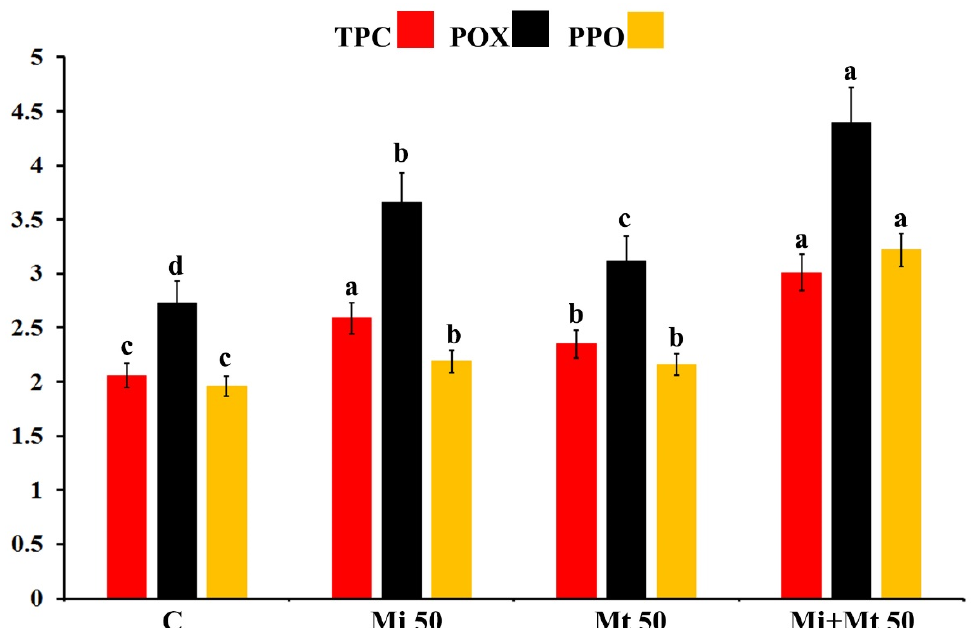
Figure 2. Histogram showing the total phenolic content (TPC, mg gallic acid equivalent/g fresh weight), and activity of peroxidase (POX, ∆ A470 min − 1 g − 1 fresh weight) and polyphenol oxidase (PPO, ∆ A 420 min − 1 g − 1 fresh weight) enzymes in date palm fruits (cv. Barhi) after 28 days of storage at 4 °C, in response to spraying with methyl jasmonate and/or melatonin solutions at 50 ppm. Where, C = untreated control fruits, Mj 50 = treated with methyl jasmonate at 50 ppm, Mt 50 = treated with melatonin at 50 ppm, and Mj + Mt 50 = treated with methyl jasmonate and melatonin at 50 ppm. For each parameter, columns superscripted with the same letter are not significantly different according to Tukey’s HSD test ( p ≤ 0.05). Each value represents the mean of three replicates. Error bars represent standard errors.